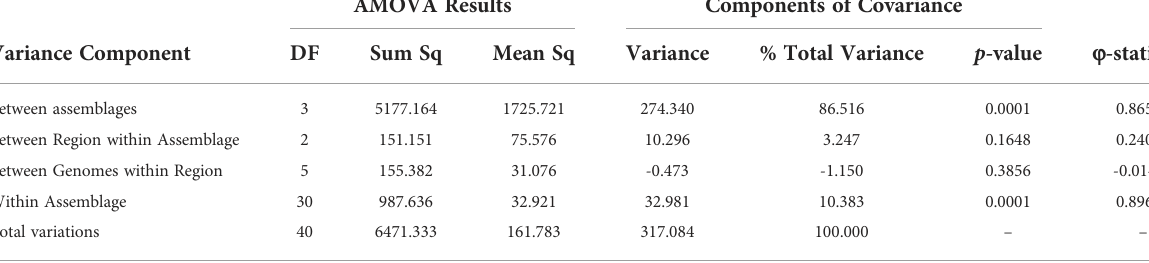
TABLE 3 Analysis of Molecular Variance results from Assemblage/Region